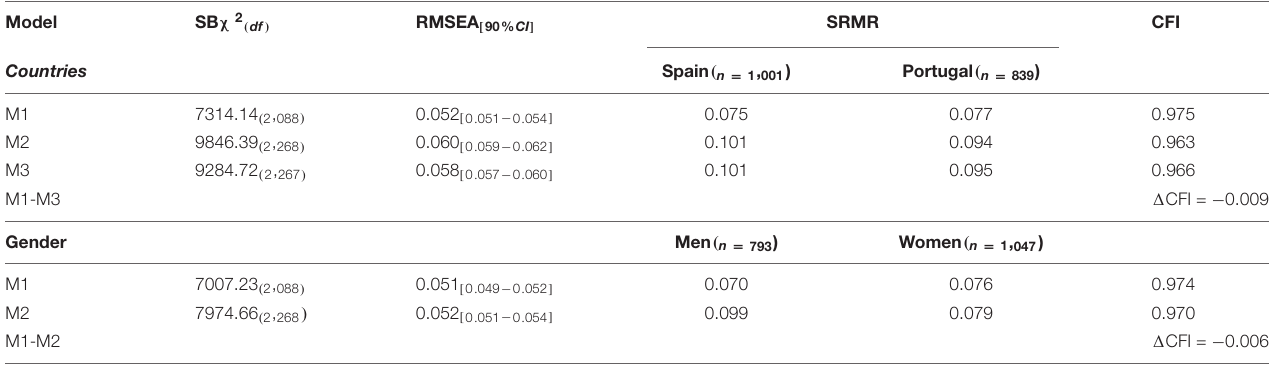
TABLE 1 | 9-Factor oblique model: factorial invariance across countries and gender.